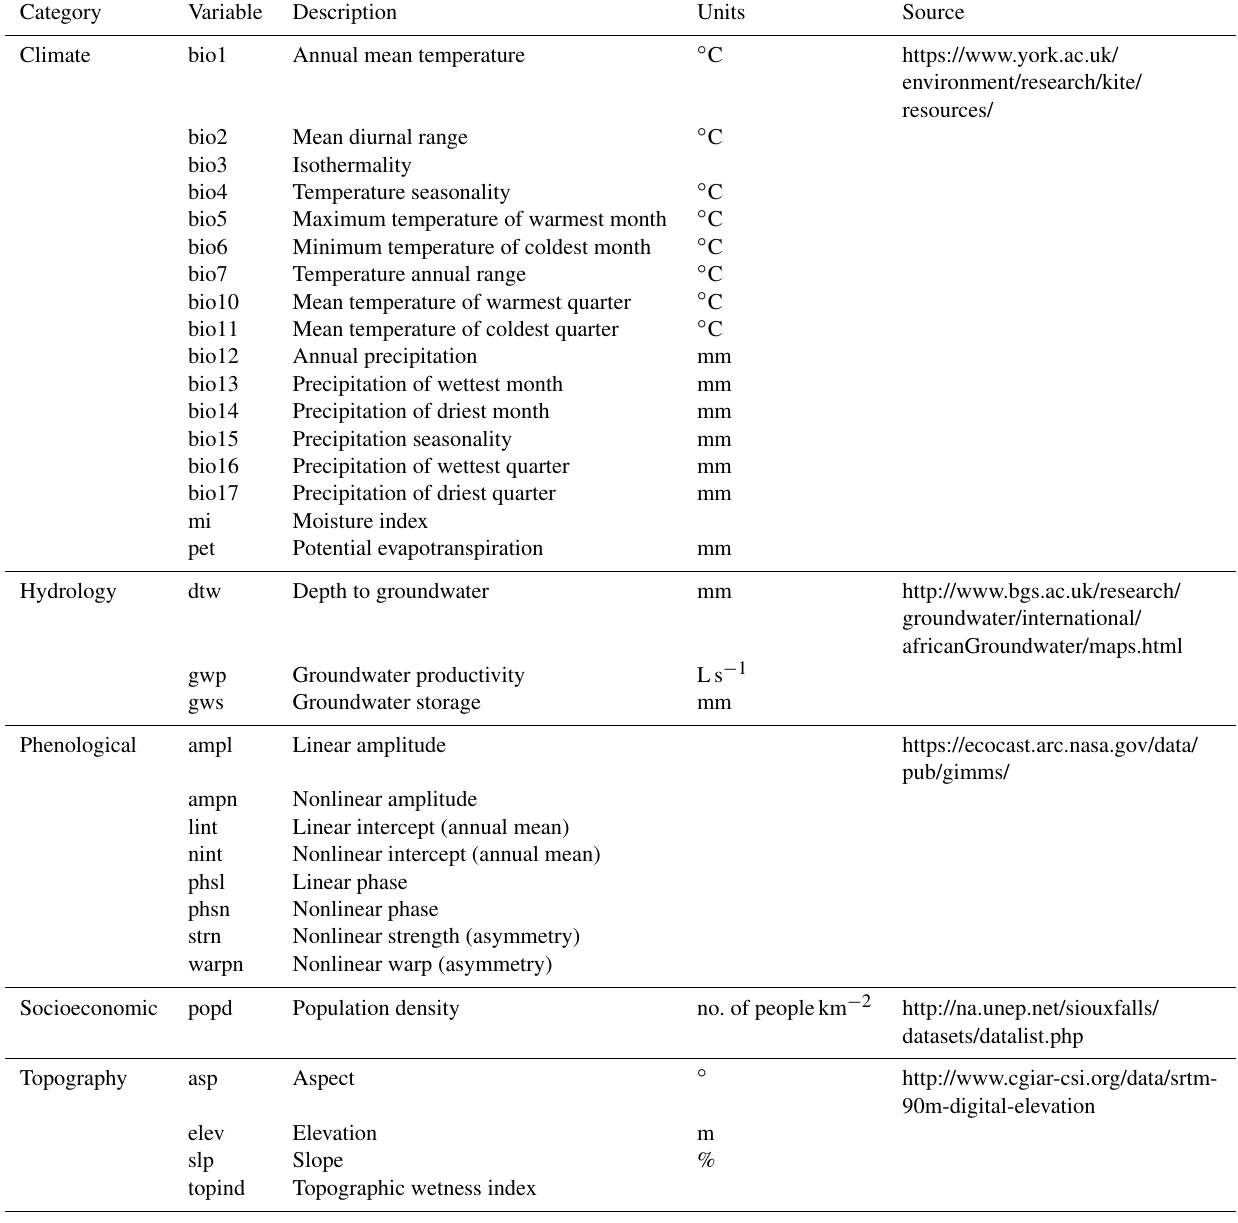
Table 2. Slowly changing (long-term average/one-time value) predictors considered for LULCC estimation and their data sources. Climate, remote sensing, and population predictors were considered as annually changing as well. Dynamic (annual) variables are distinguished with a “.d”